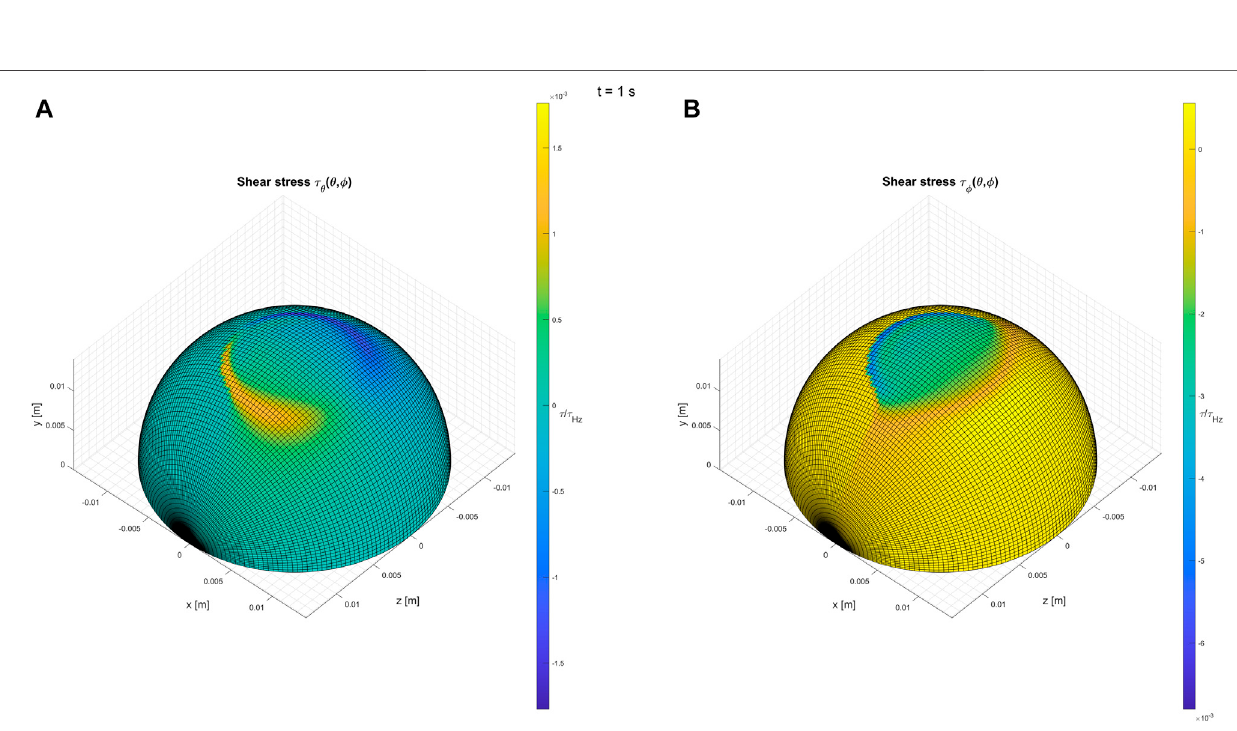
Frontiers in Mechanical Engineering |